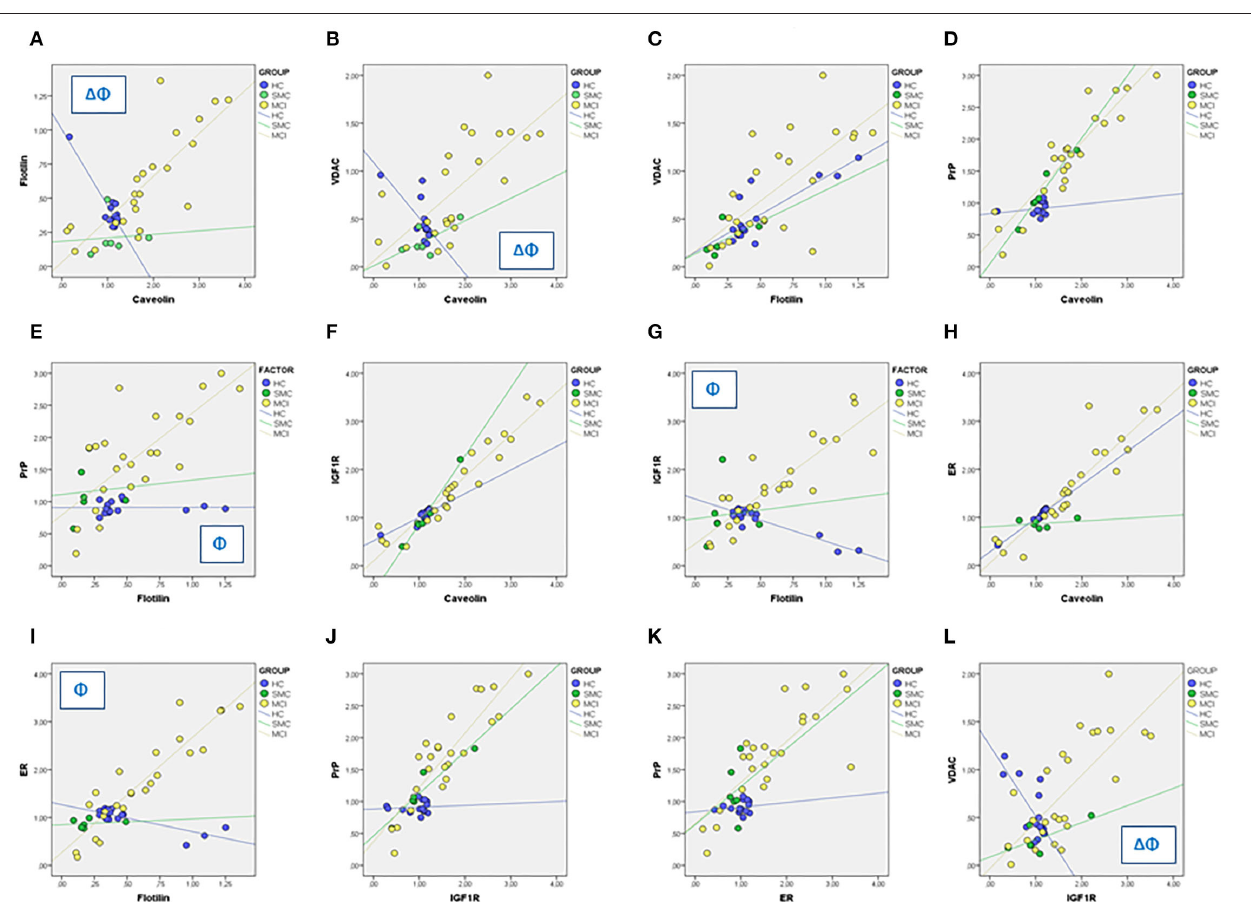
factor score 2 allows the statistical differentiation of SMC group from HC and MCI groups ( Figure 5B